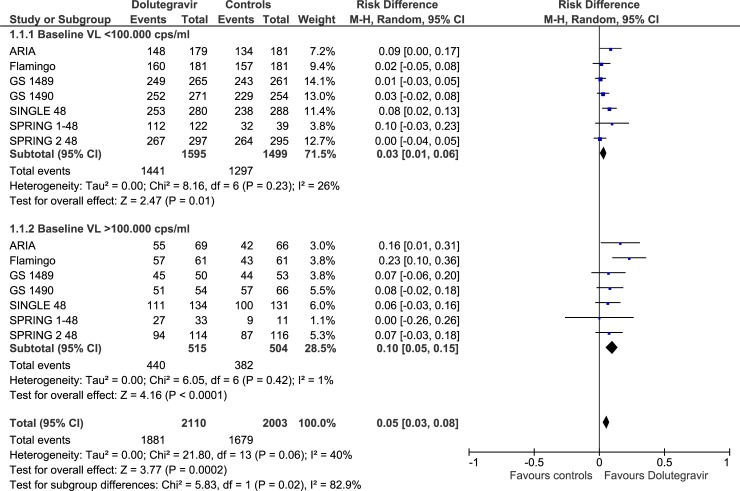
Forest plot of comparison.Doultegravir vs comparators, outcome: VL<50 copies at 48 weeks.